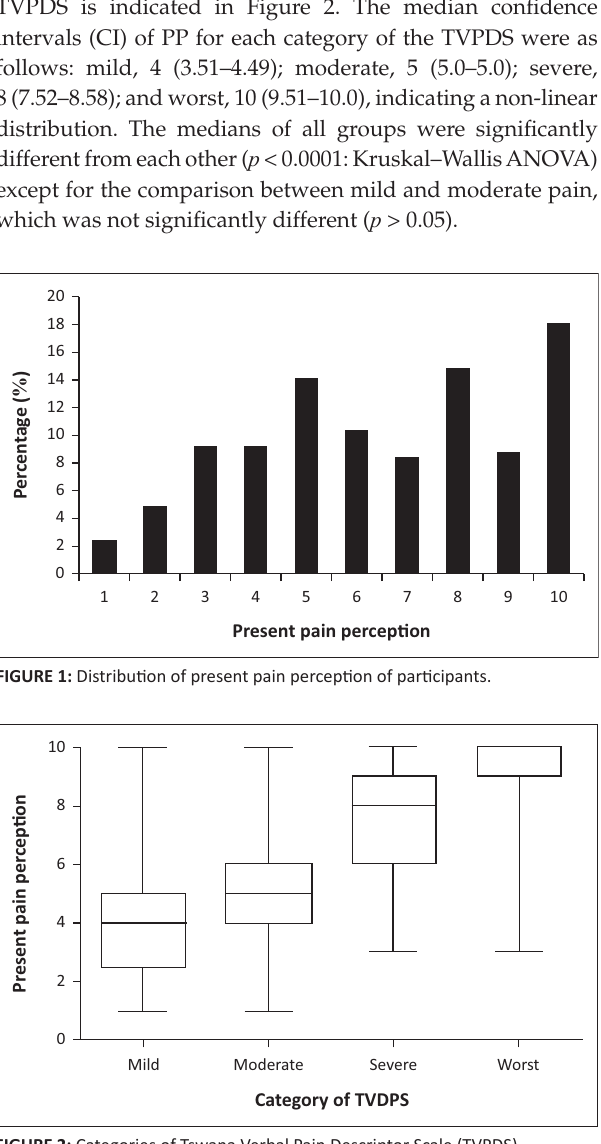
FIGURE 2: Categories of Tswana Verbal Pain Descriptor Scale